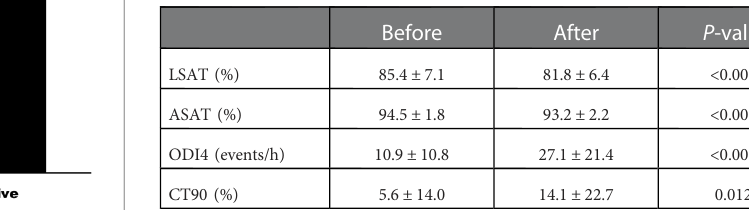
TABLE 1 Changes of pulse oximetry variables after surgery in the 36 patients with bilateral nasal